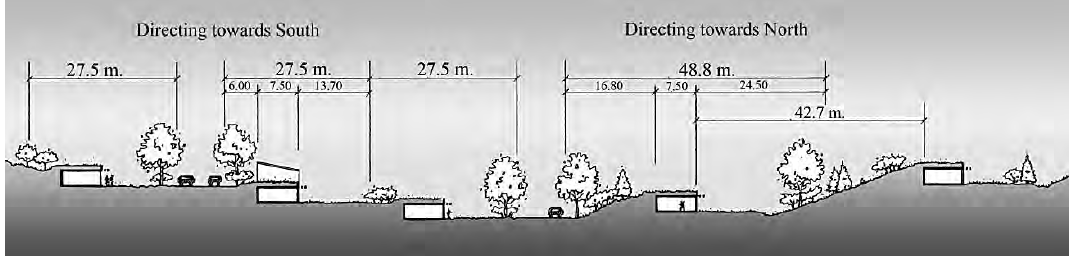
Figure 10. Cross-section showing the differences for the required distance regardingorientation towards the Sun. (Carmody and Sterling 1985).